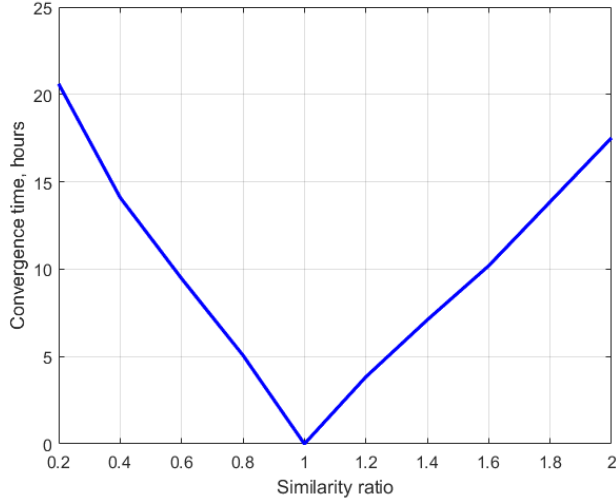
Figure 12. Time of reconfiguration for the resizing of the tetrahedron.